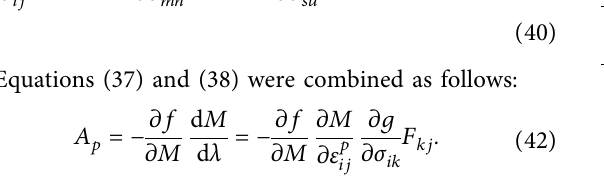
Table 1: Parameters of the state-dependent constitutive model for